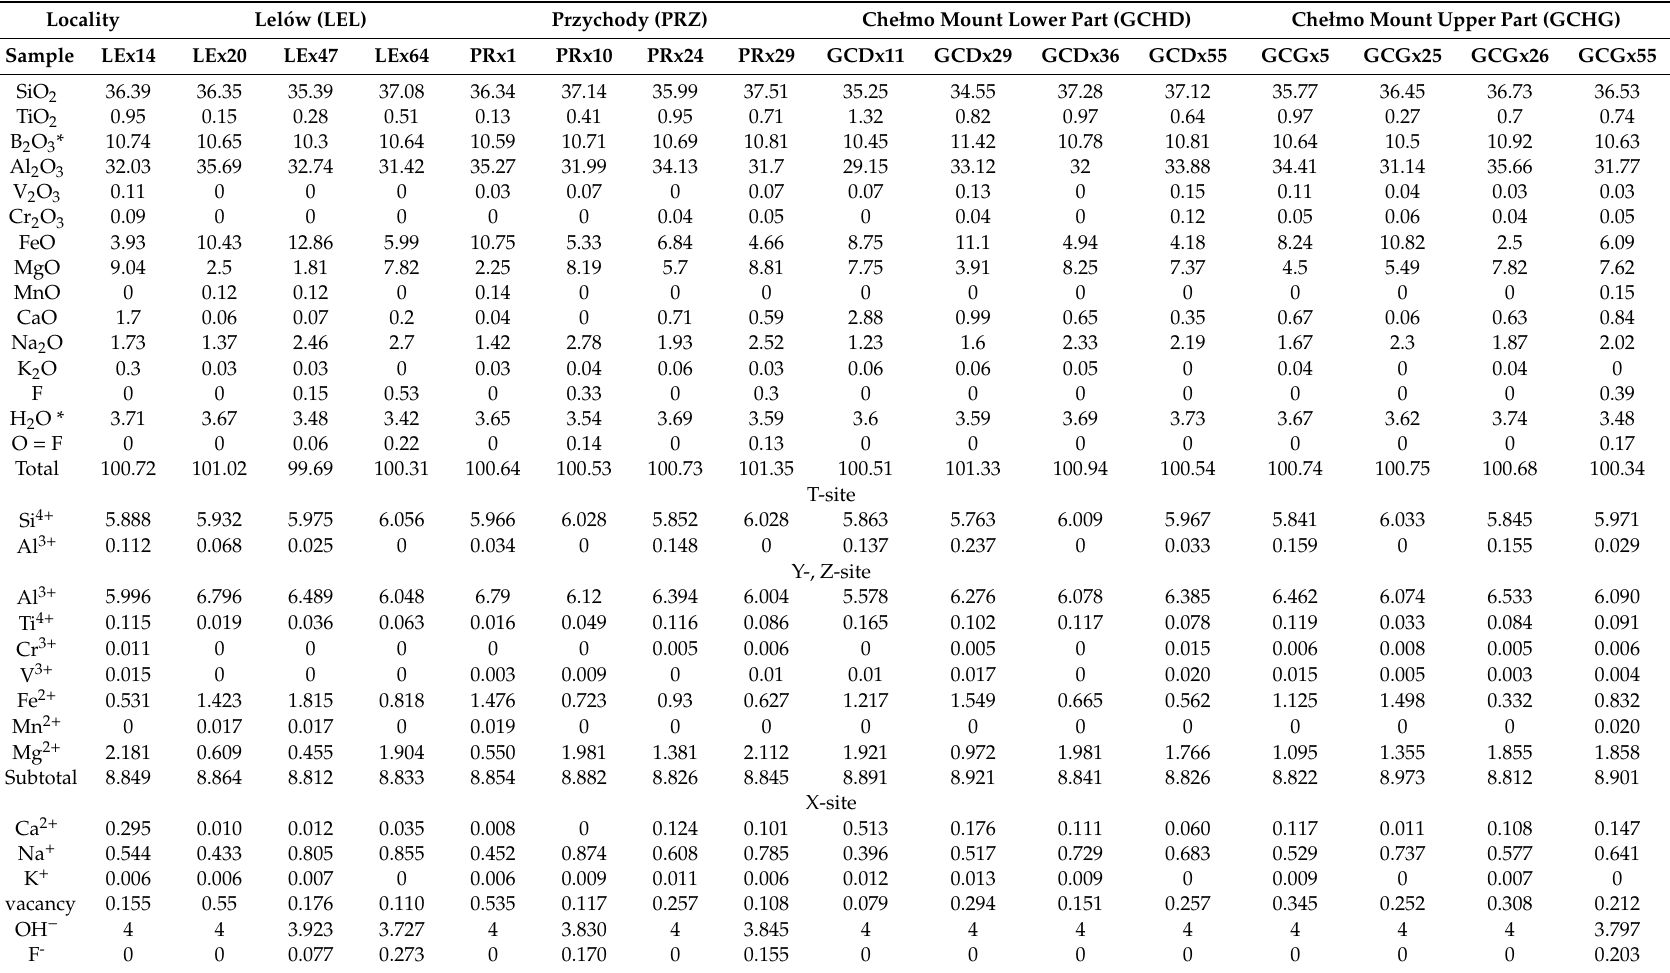
Table 1. Representative microprobe analyses of the examined tourmaline grains from the Albian deposits of the Miech ó w